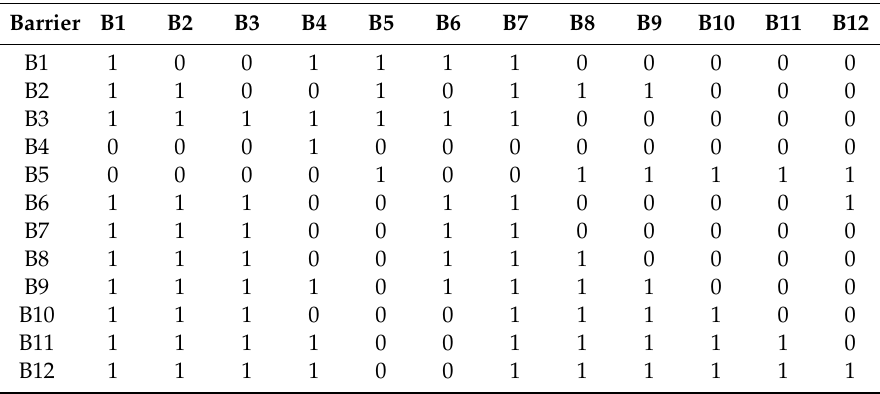
Table 3. The initial reachability matrix